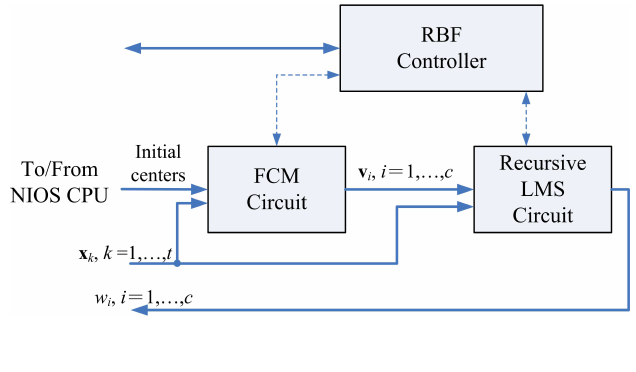
Figure 2. The proposed RBF architecture.